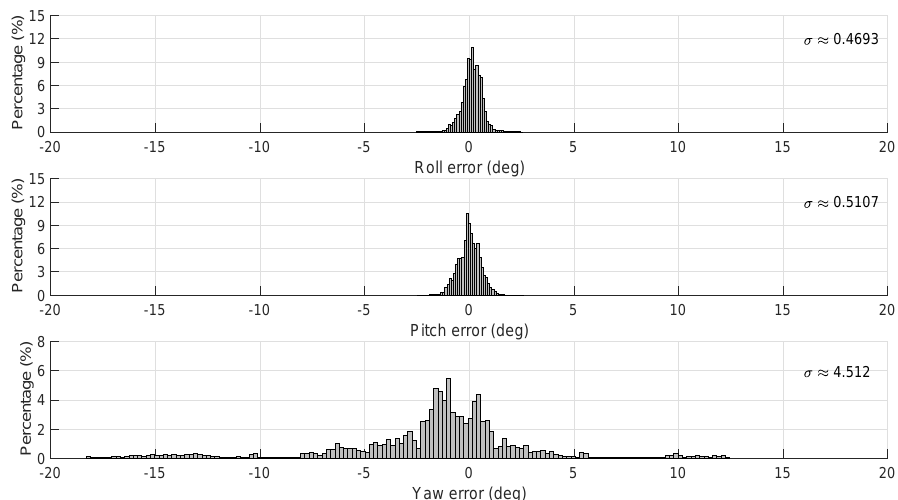
Figure 10. Orientational Root Mean Square Error (RMSE) errors of an Xsens motion tracker during a measurement of approximately 2